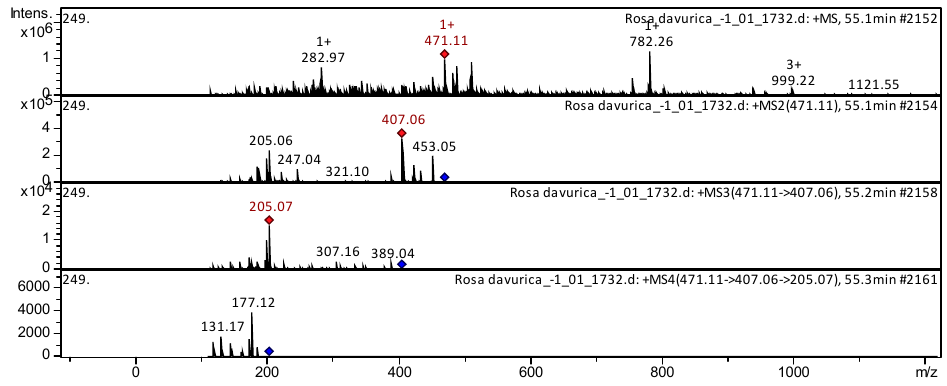
Figure 10. CID-spectrum of (S)-Flavogallonic acid from extracts of R. davurica , m / z 471.11. The polyphenol composition distribution table of varieties Rosa rugosa Thumb., Rosa davurica Pall., and Rosa acicularis Lindl. is shown below [Table 1]. The comparison table shows the presence of some polyphenols in three types of the genus Rosa (kaempferol, ellagic acid). Some polyphenols are present in only one variety of the genus Rosa . Table 1. The flavonoid composition distribution of varieties R. rugosa Thumb., R. davurica Pall., and R. acicularis Lindl. Blue square—presence in extracts of R. rugosa ; red square—in extracts of R. davu- rica ; green square—in extracts of R. acicularis . No.